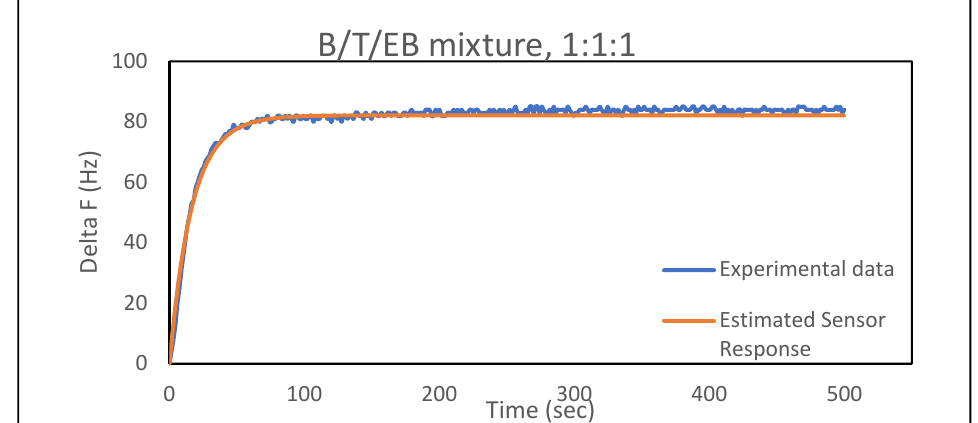
Figure 4. Comparison of experimental data and estimated sensor response from the model for B–T–EB mixture (1–1–1) in the PEMA–DINCH film. Table 7. Comparison of regressed mole fractions y 1, amb , y 2, amb , and y 3, amb from Equation (8) to actual mole fractions y 1, act